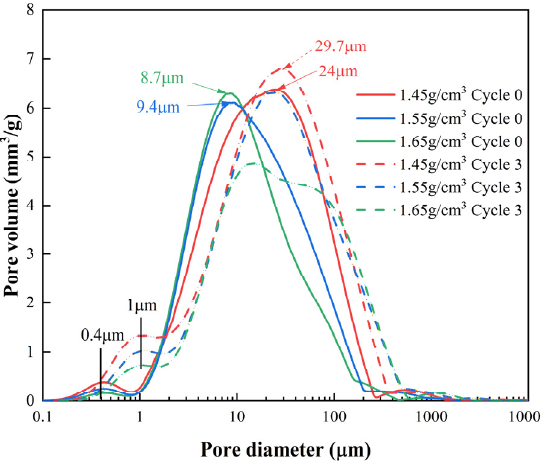
Figure 6. PSD of compacted loess samples